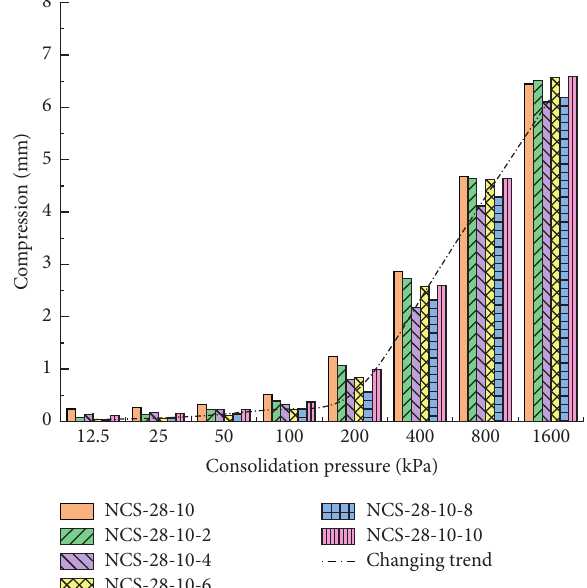
Figure 10: d - p histogram of NCS-28 with different consolidation